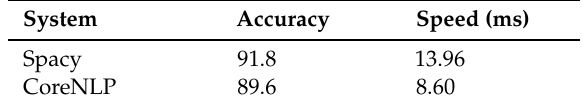
Table 1. Accuracy comparison between Spacy and CoreNLP.